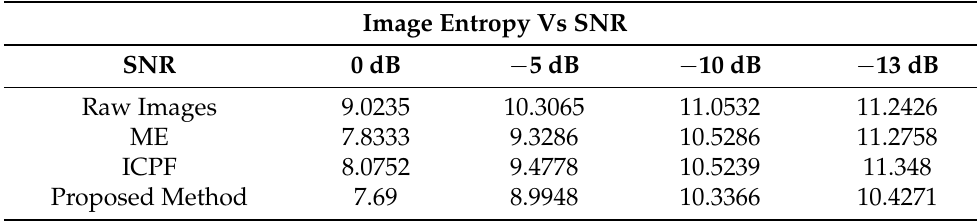
Table 10. Entropy of high-speed compensated images with different SNRs based on Yak-42 mea- sured data.